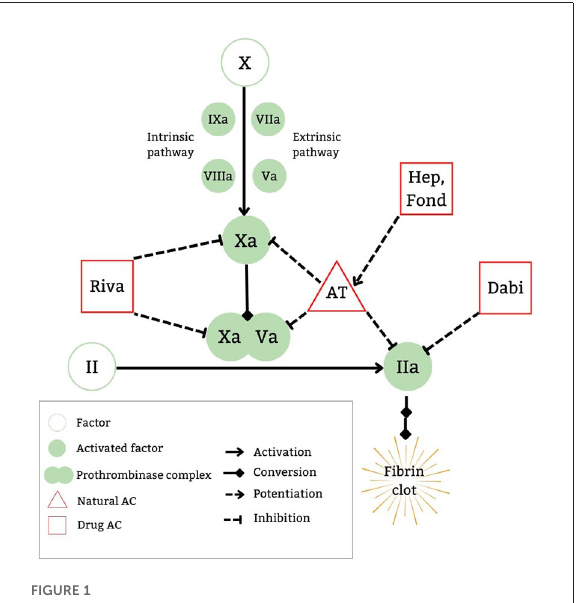
FIGURE1 DOAC mechanism of action. AC, anticoagulatnt; AT, antithrombin; Dabi, dabigatran etexilate; Fond, fondaparinux; Hep, heparins; Riva, rivaroxaban.